Question: Provide a publication-style caption for this figure.
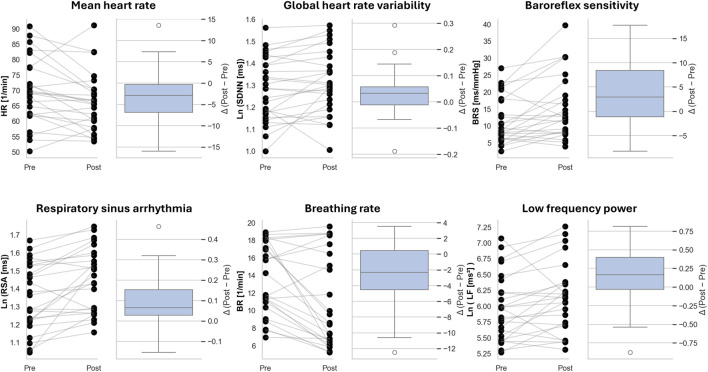
Answer: Follow-up paired-samples t-tests comparing autonomic indices at baseline (Pre) and after the biofeedback intervention (Post). Abbreviations: HR heart rate; SDNN standard deviation of heart beat intervals; BRS baroreflex sensitivity; RSA respiratory sinus arrhythmia; BR breathing rate; LF log-transformed low frequency power of heart rate variability, Ln log‐transformed measure.